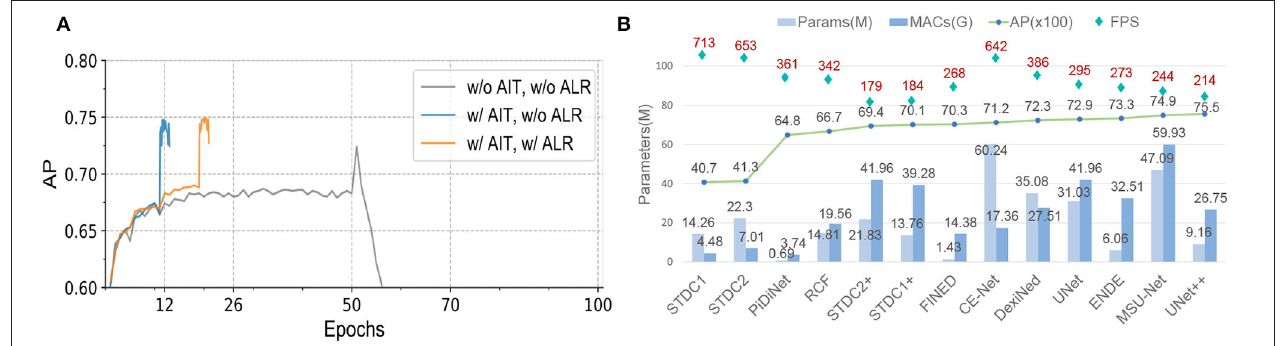
FIGURE 14 | (A) Training schedules. “AIT” is adaptive iteration training. “ALR” is adaptive learning rate. We evaluate UNet++ (Zhou et al., 2019) on the validation set. (B) Comparison of network parameters, running efficiency and edge detection performance. “MACs” is multiply-accumulate operation. “FPS” is the average speed by evaluating 10,413 images with a resolution of 256 ×